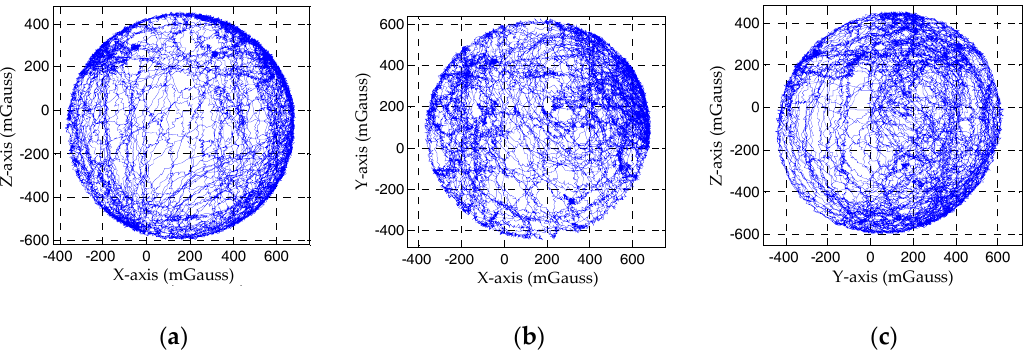
Figure 6. The magnetic field measurements of rotation: ( a ) Magnetic field measurements of X-Z plane; ( b ) Magnetic field measurements of X-Y plane; ( c ) Magnetic field measurements of Y-Z plane. Table 1. Summary of the calibration parameters from the magnetometer calibration test.